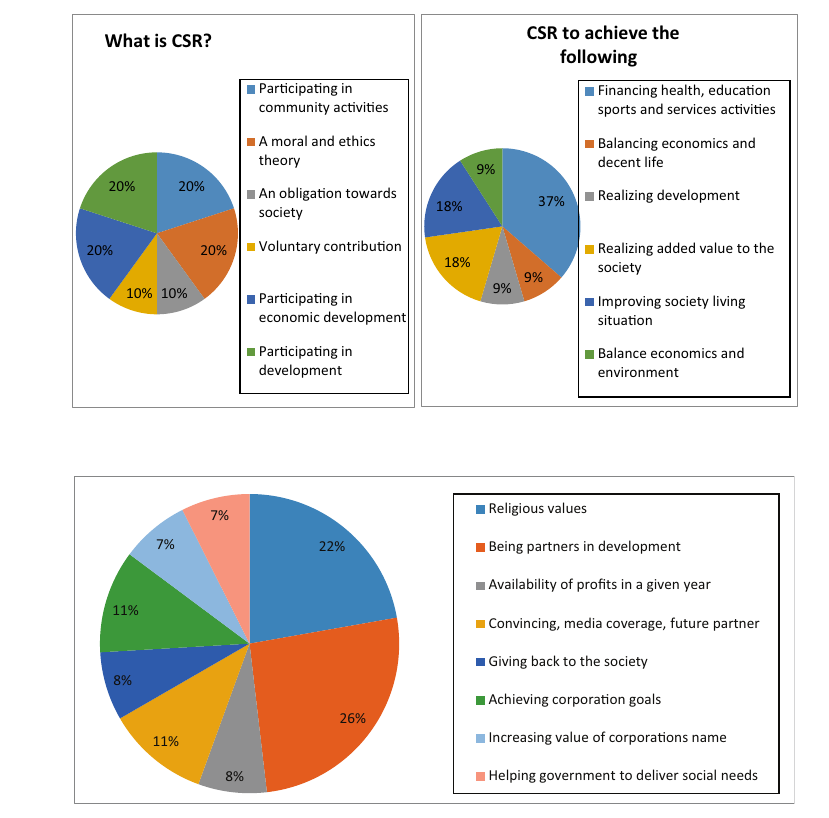
Figure 2. Reasons